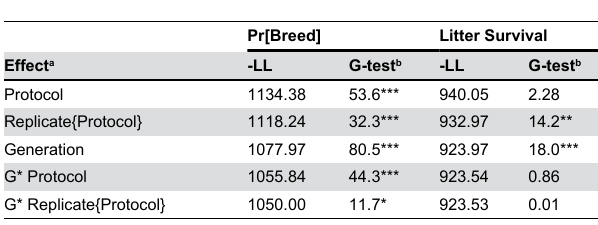
Table 4. Statistical tests of effects of sex, breeding protocol, replicate, and generation on dichotomous measures of reproductive performance, from logistic regression models.